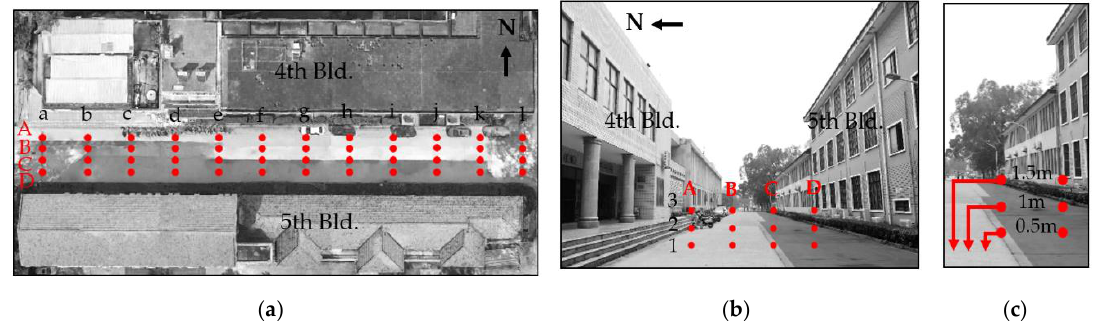
Figure 7. Locations of analysis points in the pedestrian space between the teaching buildings. ( a ) Measurement points in the analyzed pedestrian space; ( b ) measurement points along the height direction; ( c ) elevations of measurement points along the height direction.